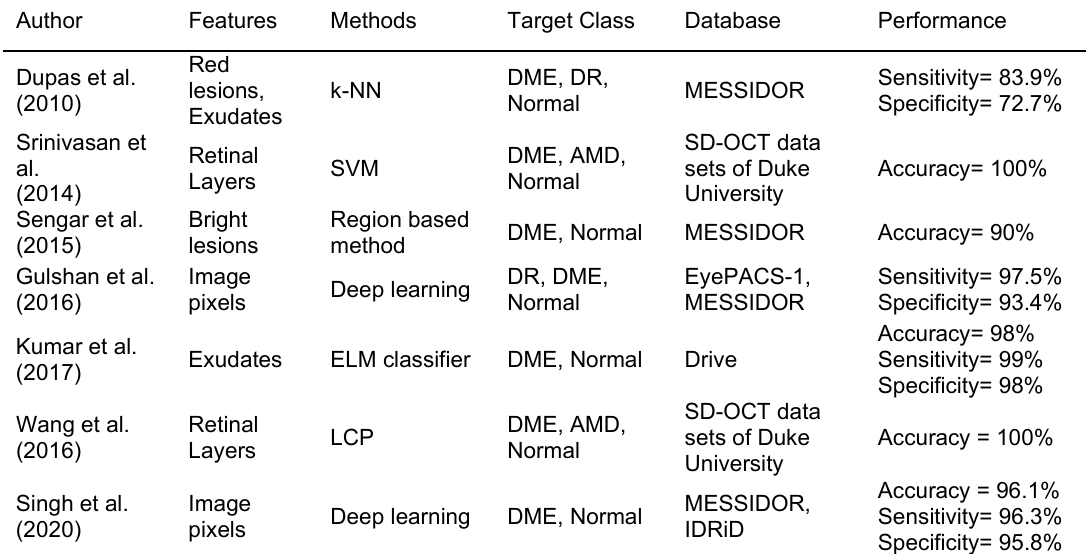
Table 2. State-of-the-Art of DME